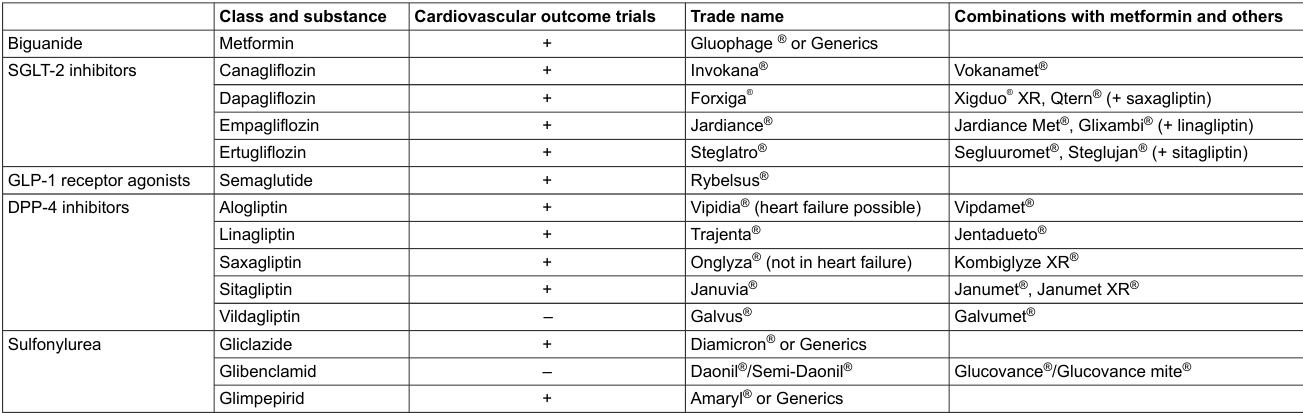
Table 4: Oral antidiabetic medications with/without cardiovascular outcome trials.